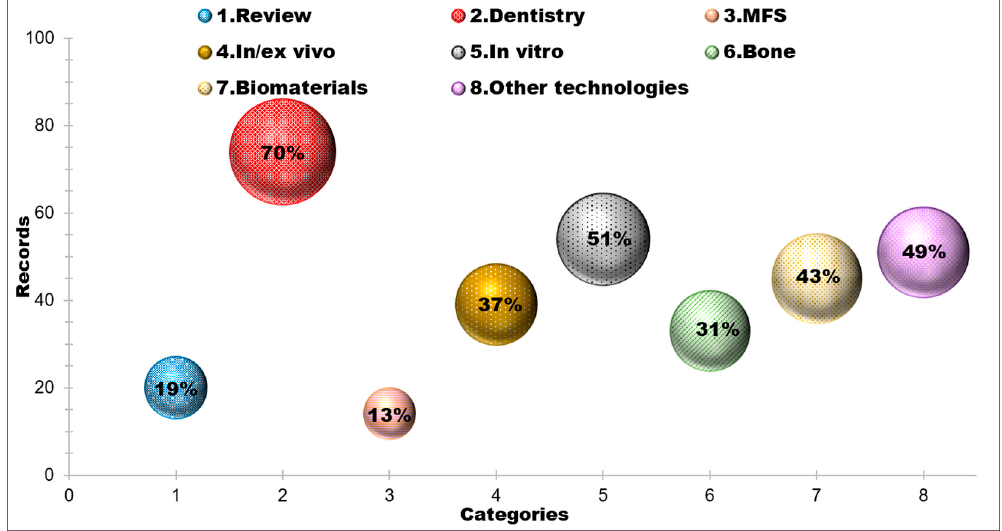
Figure 3. Distribution of the studies discussed in the text according to the topics indicated as the categories ( 1 – 8 ) on the horizontal axis; the number of records discussed in the text is indicated as an absolute value on the vertical axis and as a percentage value of the total studies considered in the graphical representation.